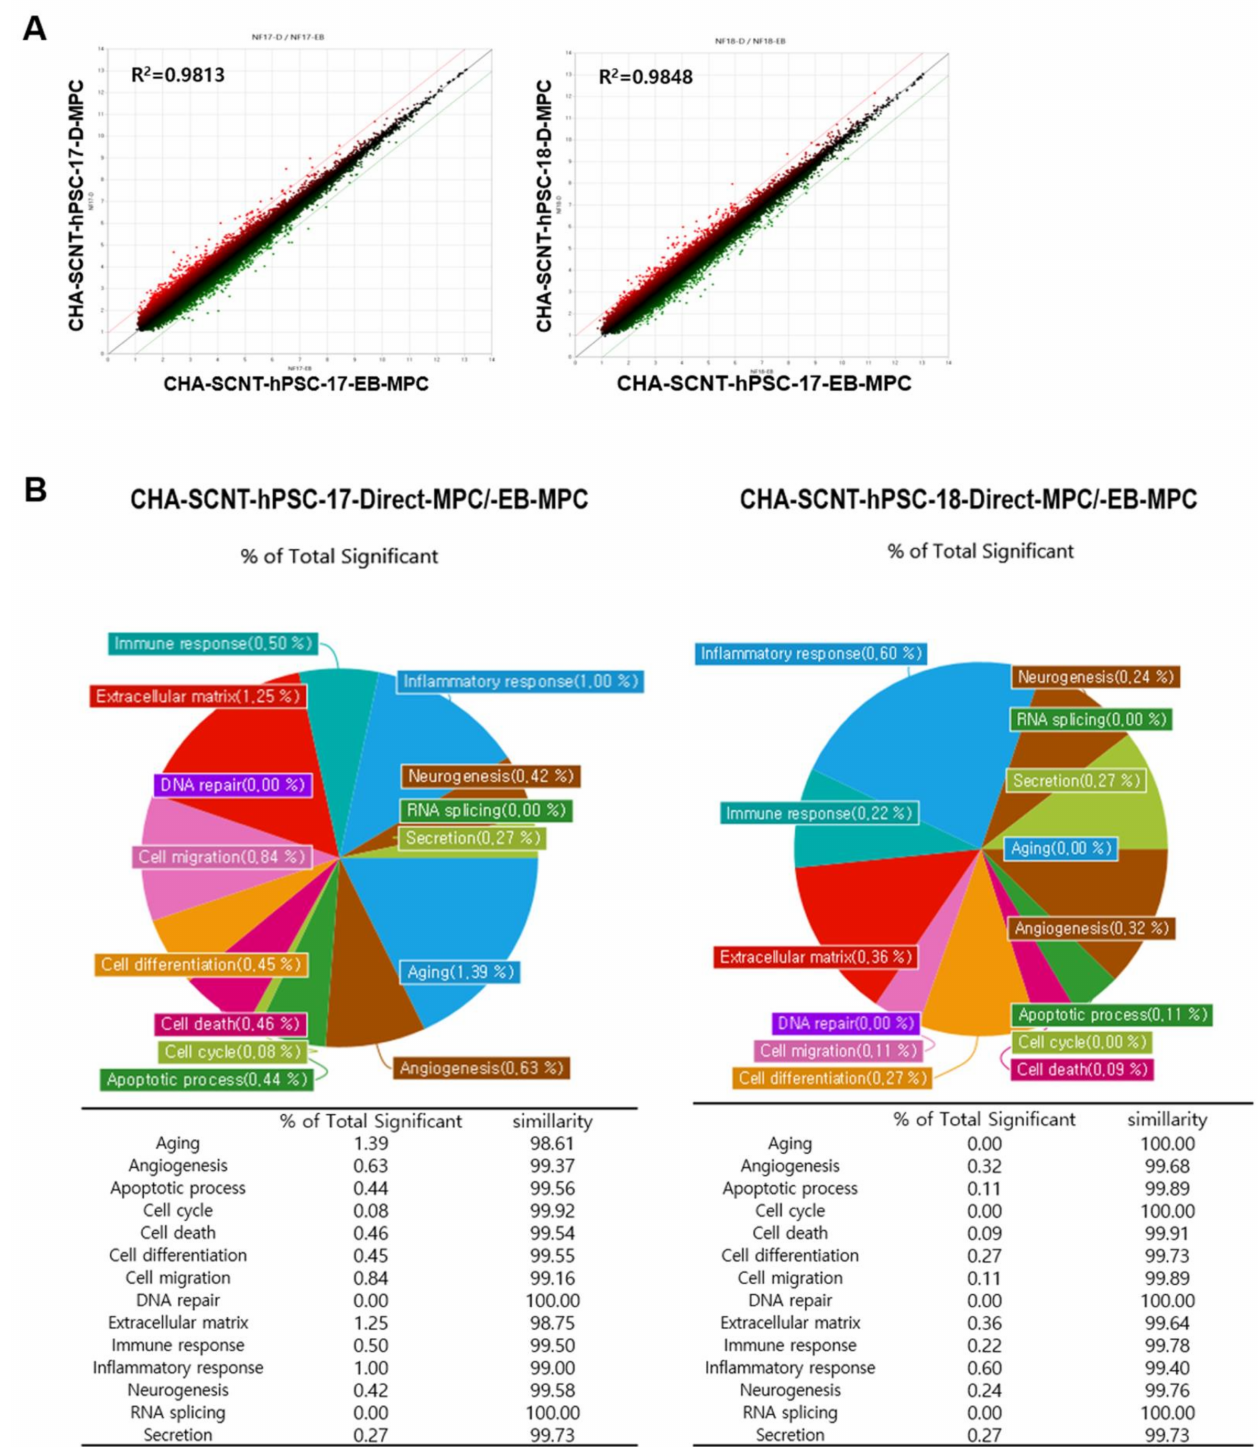
Figure 5. Correlation of gene expression profiles between EB-MPCs and Direct-MPCs derived from the same human SCNT-hPSC line. ( A ) Scatter plot comparing microarray gene expression data of EB-MPCs and Direct-MPCs. The x and y values on the scatter plot are the average normalized signal values shown on a log2 scale. The red and green lines are fold change lines with a default change of 2.0. ( B ) Pie chart showing the percentage of genes with significantly different expression among genes that are related to each gene category in the EB-MPCs and